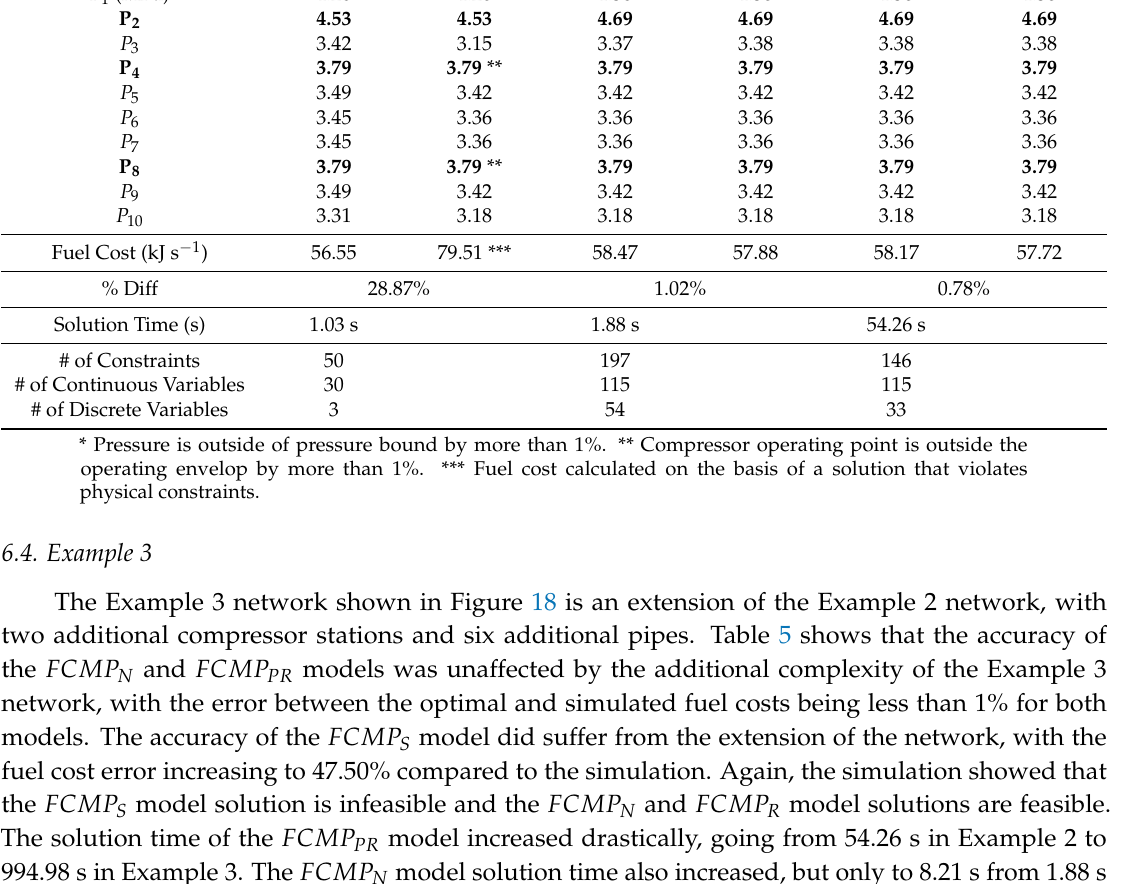
FCMP S FCMP N FCMP PR Variable Optimization Simulation Optimization Simulation Optimization